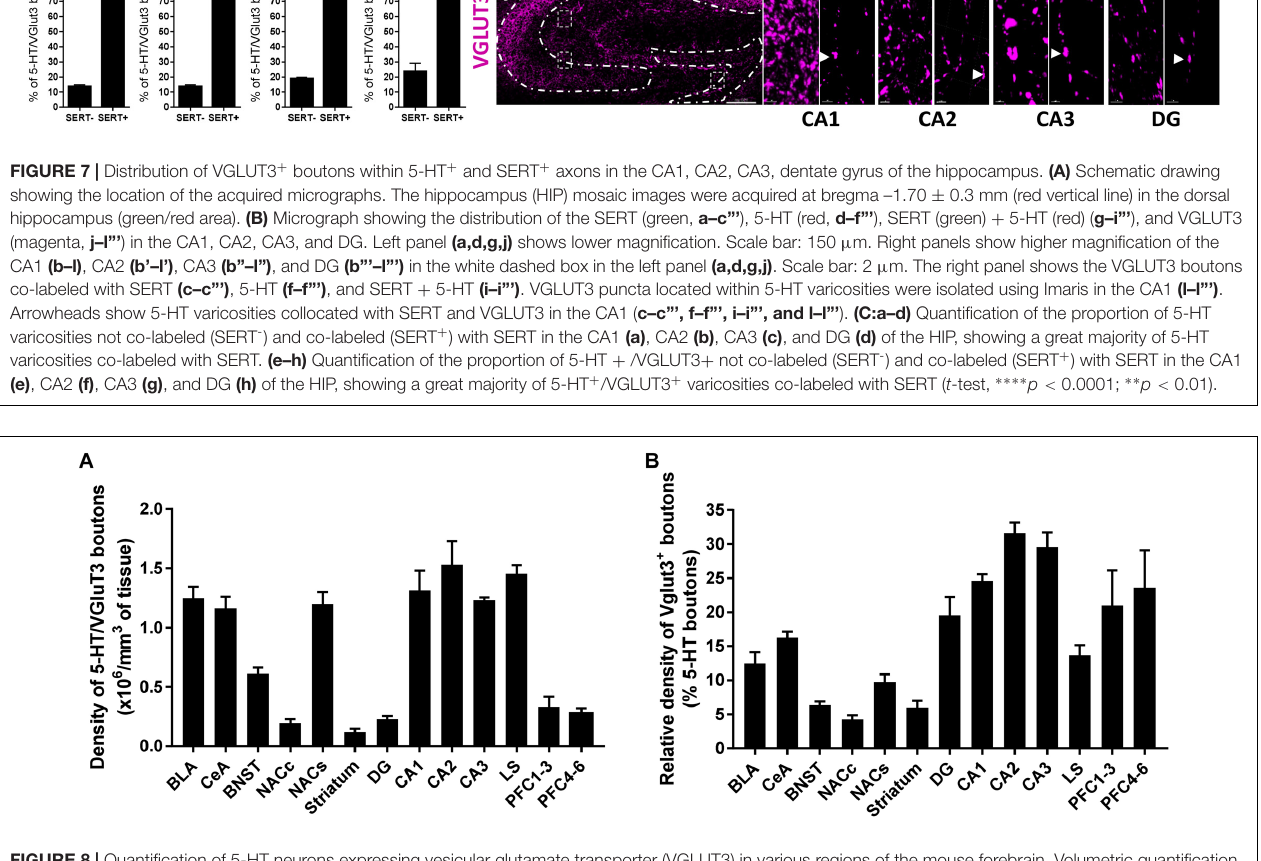
FIGURE 8 | Quantification of 5-HT neurons expressing vesicular glutamate transporter (VGLUT3) in various regions of the mouse forebrain. Volumetric quantification of the density of VGLUT3 immunoreactive boutons within 5-HT-labeled fibers in each brain region. The results are expressed as density of boutons per 10 6 mm 3 of 5-HT + fiber (A) , or percent of boutons in 5-HT + fiber (B) and represented as the mean ±